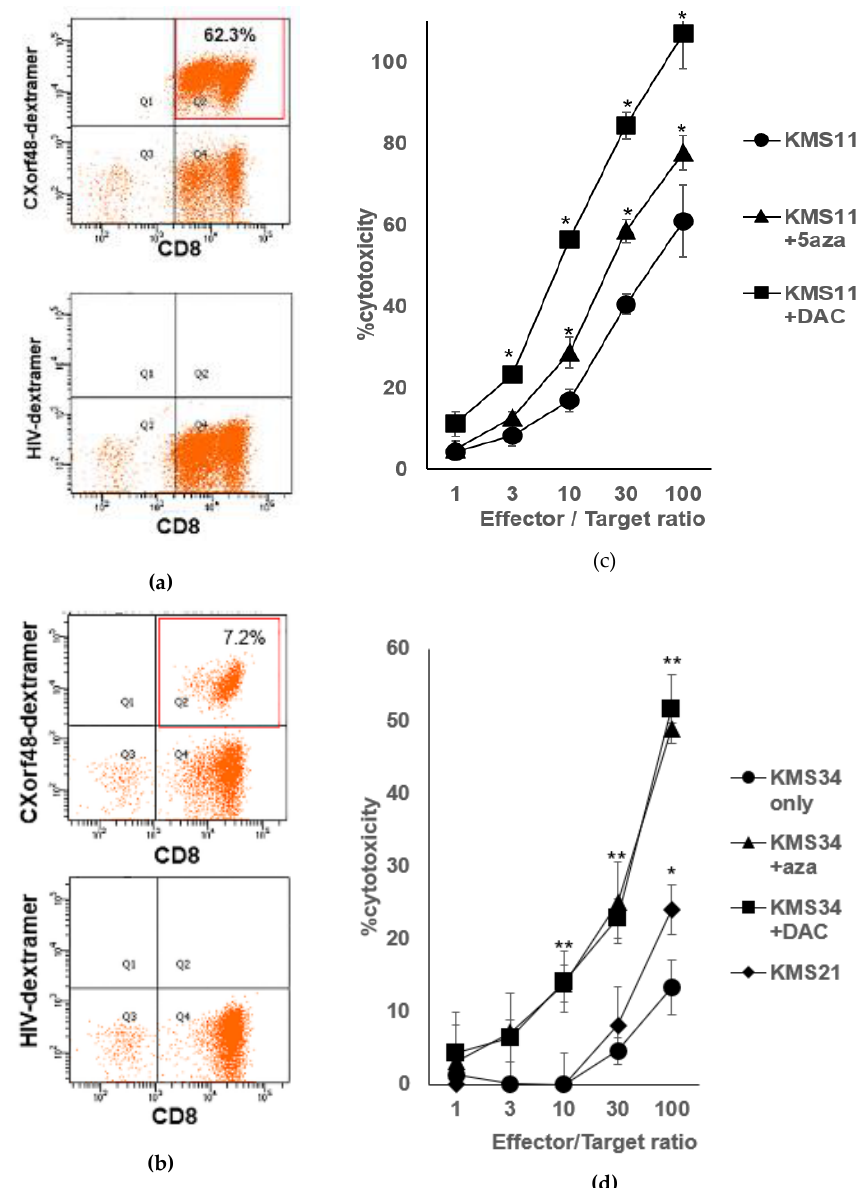
Figure 5. Activities of CXorf48-specific CTLs against demethylating agents-treated myeloma cells. ( a , b ) CXorf48-specific CTLs induced from PBMNC of healthy donors using CXorf48 49 – 57 peptide were stained with dextramer specific to CXorf48 49 – 57 peptide (upper) or dextramer specific to HIV-derived peptide (lower), and analyzed by flow cytometer. ( c , d ) Cytotoxicity of CXorf48-specific CTLs against myeloma cell lines, KMS11 or KMS34 (HLA-A*24:02-positive, CXorf48-negative) treated with DMSO, 5-aza , or DAC was assessed by 51 Cr release assay. KMS21 (HLA-A*24:02-positive, CXorf48-positive) was used as a control. * p < 0.05, ** p < 0.01 (Student ’ s t -test, against KMS11 only or KMS34 only).